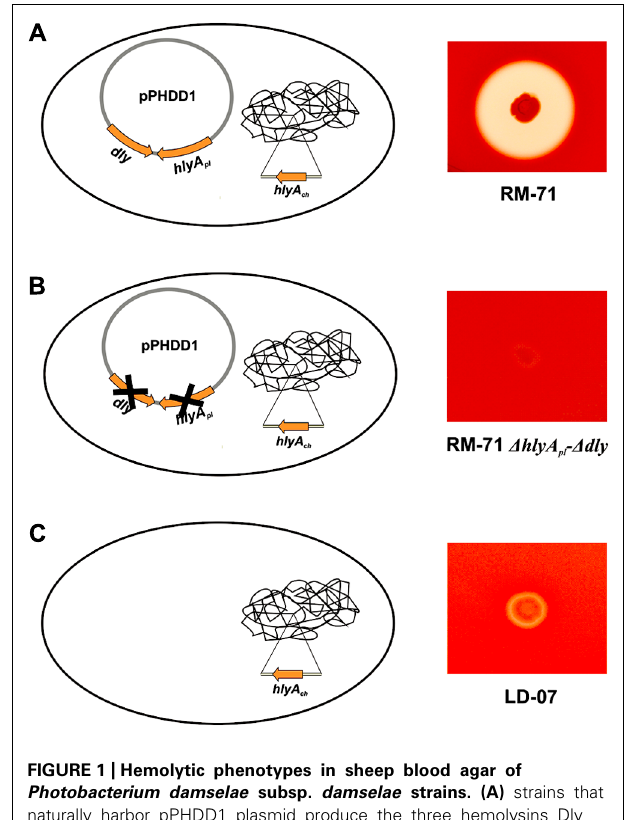
FIGURE 1 | Hemolytic phenotypes in sheep blood agar of Photobacterium damselae subsp. damselae strains. (A) strains that naturally harbor pPHDD1 plasmid produce the three hemolysins Dly (damselysin), HlyA pl , and HlyA ch (this last one, encoded in the chromosome), and cause a wide hemolytic halo in sheep blood agar. (B) a double mutant for dly and hlyA pl genes shows a weak hemolytic phenotype, similar to that of a naturally plasmidless strain (C) , that only produces HlyA ch .